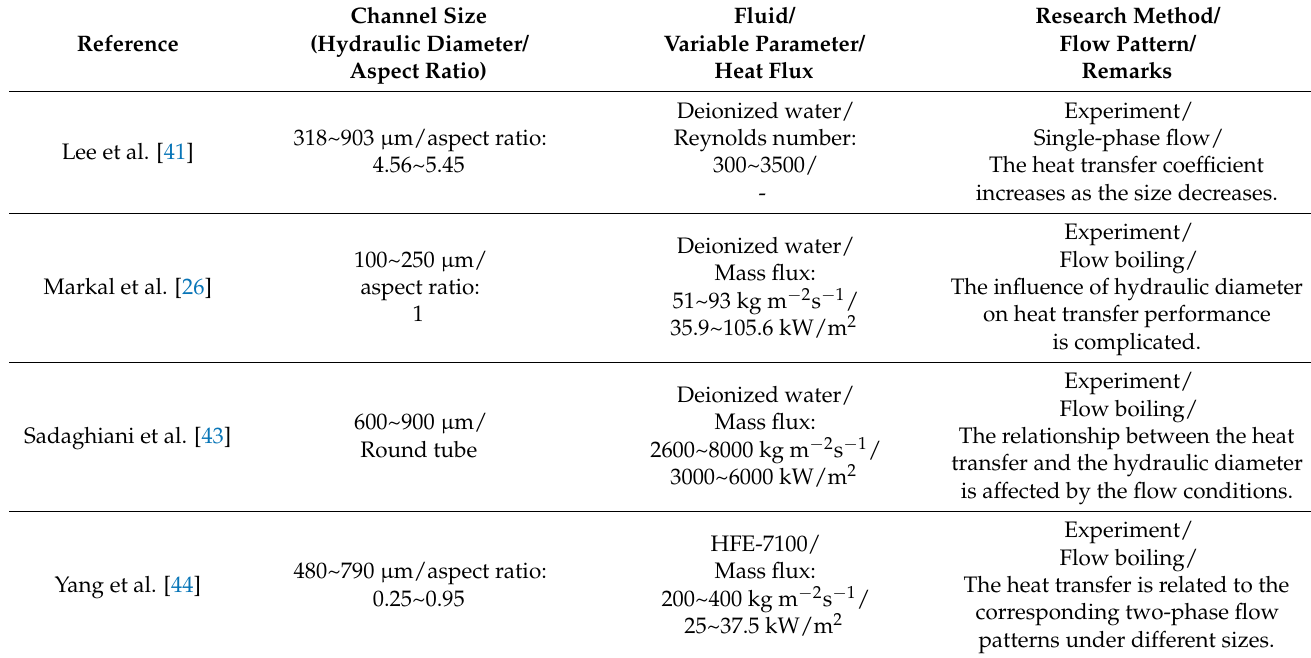
Table 1. Selected studies of hydraulic diameter on heat